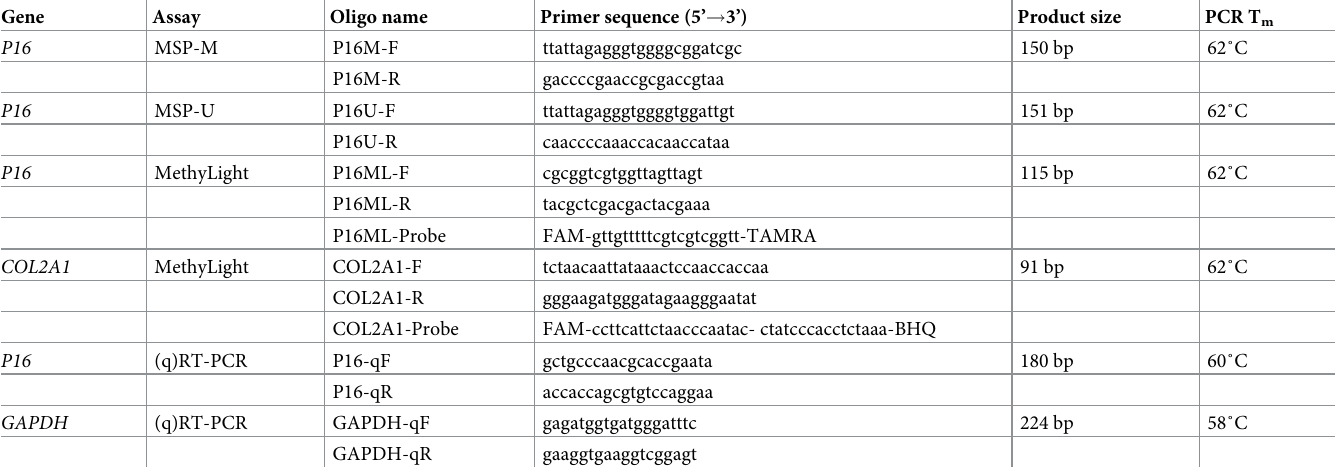
Table 1. Sequences of oligonucleotides used as primers and probes in various PCR assays. Gene